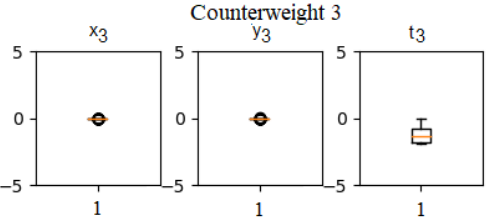
Figure A3. Box plots of partial derivatives with respect to each optimization variable when using one counterweight.